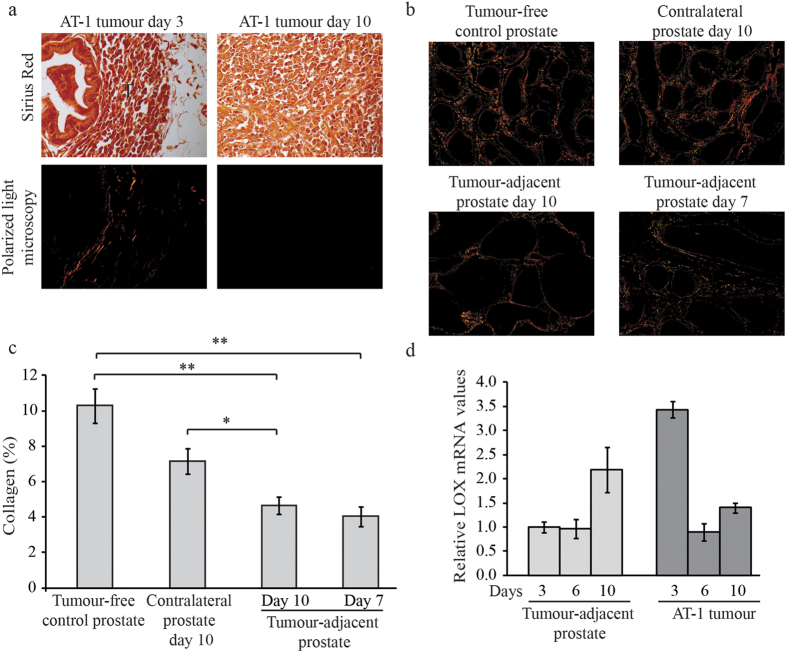
Collagen fibre density in AT-1 tumours and in tumour-adjacent non-malignant prostate tissue.(a) Representative sections of AT-1 tumours at day 3 and day 10 stained with Sirius red in both regular light microscopy and in polarized light microscopy (Original magnifications 400x, T; tumour). (b) Representative sections of tumour-adjacent prostate tissue at day 7 and 10, contralateral prostate tissue at day 10 and tumour-free control prostate tissue stained with Sirius red and shown in polarized light. (c) Quantification of Sirius red staining in tumour-adjacent prostate tissue and controls. Values are the mean collagen percentage ± SEM; n = 5–7 per group; *p < 0.05, **p < 0.01. (d) Relative mRNA expression of Lox and in AT-1 tumours and in non-malignant tumour-adjacent rat prostate tissue at 3, 6 and 10 days after tumour cell implantation (n = 2–8 per group) expressed in relation to the levels in tumour-adjacent prostate tissue at day 3.